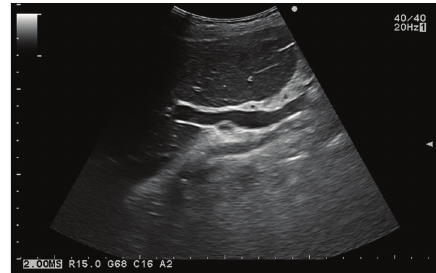
Figure 1: Ultrasonography with the typical technique and the probe placed at the right hypochondrium could not locate the gallbladder at the plane of the liver